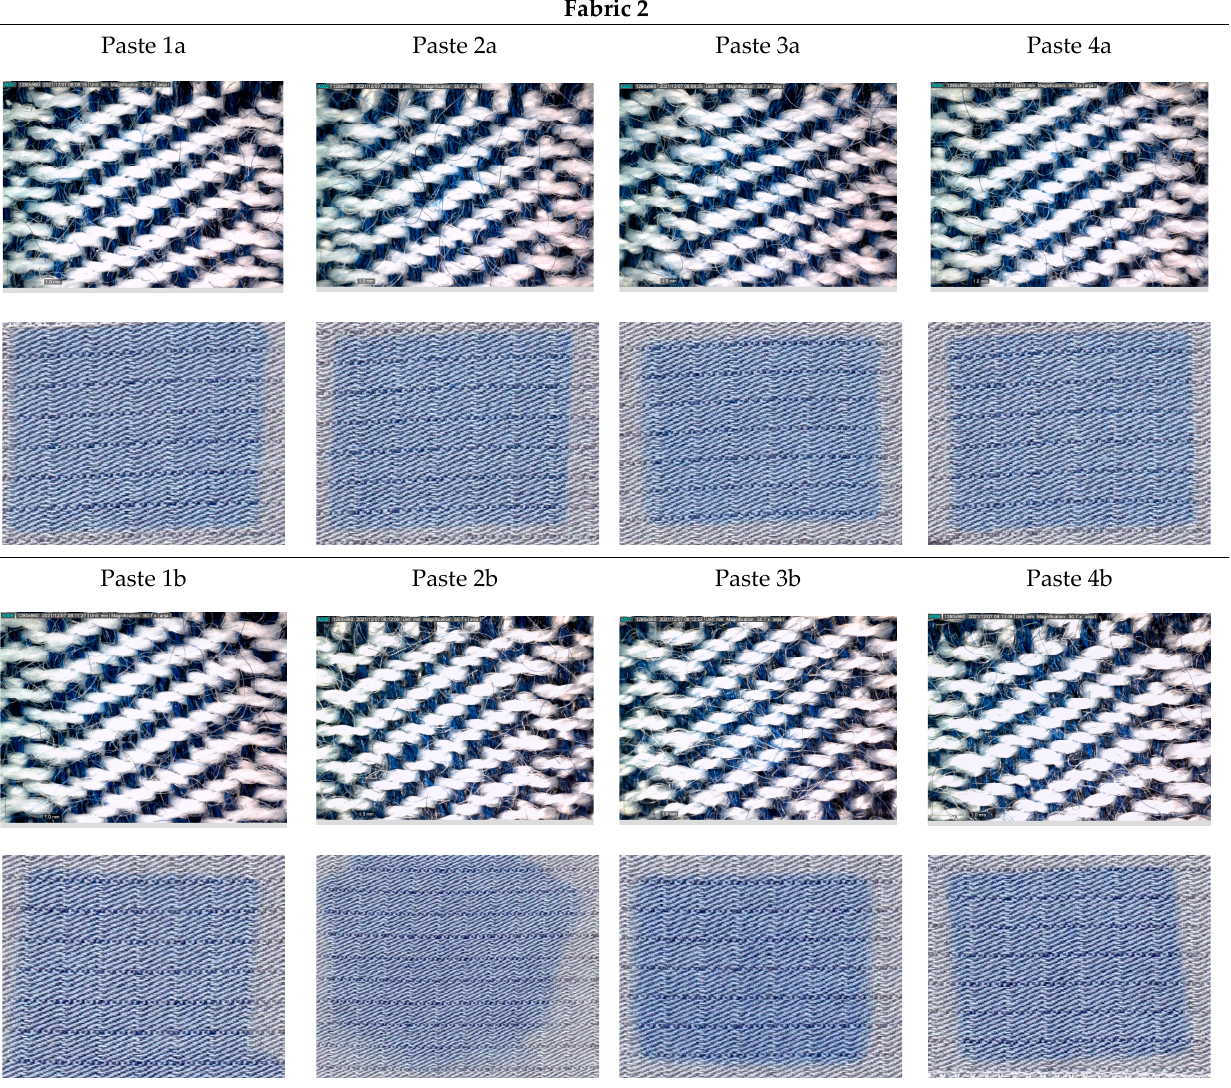
Figure 2. DinoLite microscopic and scanned images of printed Fabric 2.